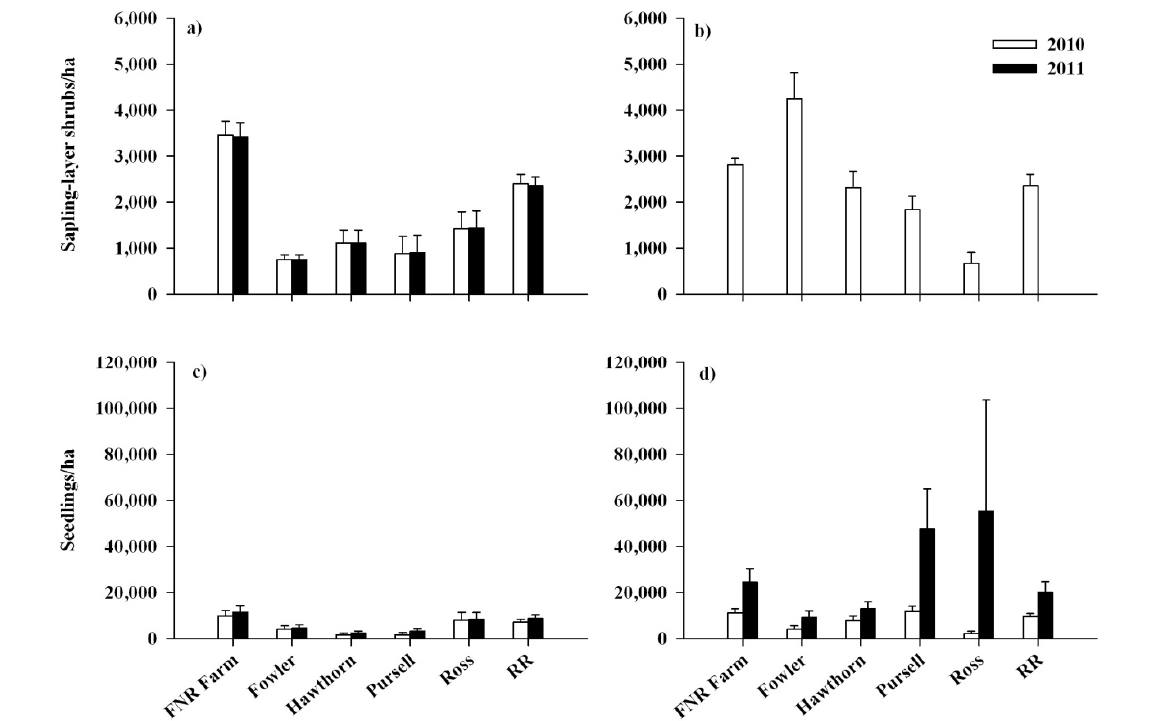
Figure 2. Mean Lonicera maackii sapling-layer densities (shrubs/ha for shrubs ≥ 1.37 m tall) in reference areas ( a ) and removal areas ( b ) and seedlings/ha (shrubs < 1.37 m tall) in reference areas ( c ) and removal areas ( d ), in 2010 and 2011, at six mixed-hardwood forests in central Indiana. Error bars are ± 1